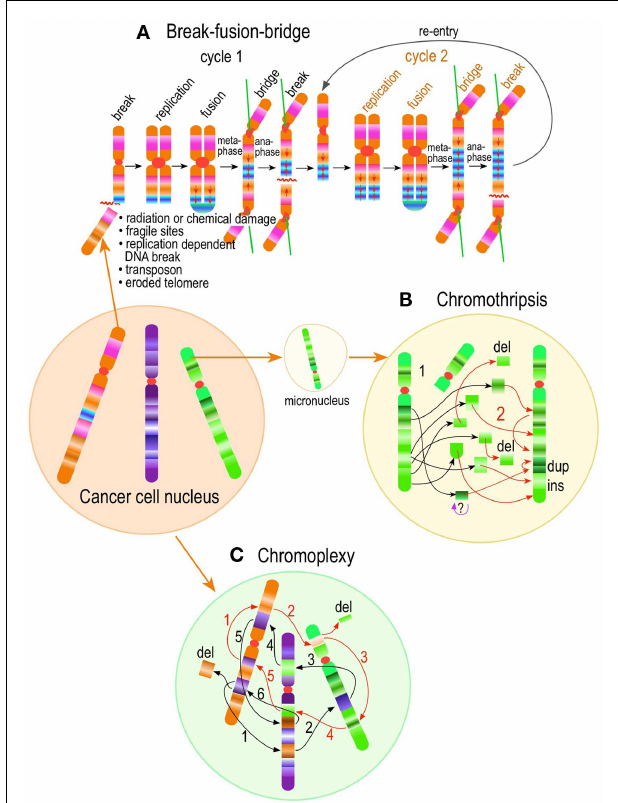
FIGURE 7 | Chromoanagenesis in cancer . Complex structural chromosome rearrangements in cancer, involve stepwise or punctual chromosome restructuring. It includes stepwise classic intra or inter-chromosomal break-fusion-bridge cycles (A) ; chromothripsis (B) , which are punctual localized highly complex chromosome fragmentation (1) and rejoining (2) events, and chromoplexy (C) , in which complex linked translocation events involving multiple chromosomes presumably occur simultaneously. 1 through 6 (black typeface) and 1 through 5 (orange typeface) represent two such linked “chained”